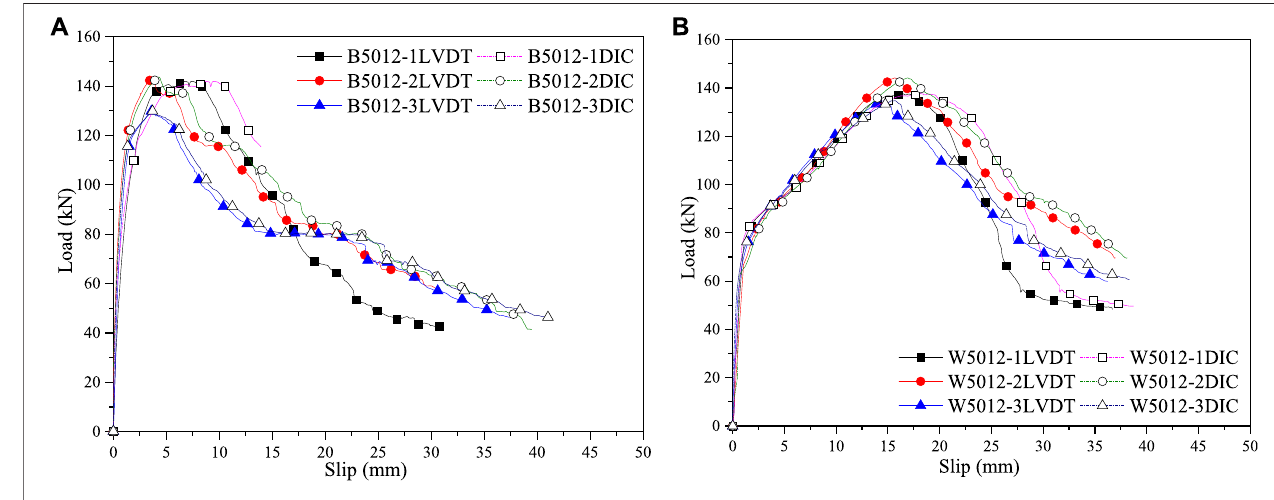
FIGURE 10 | Load-slip curves measured of connections by LVDT and DIC (A) B5012 and (B) W5012.